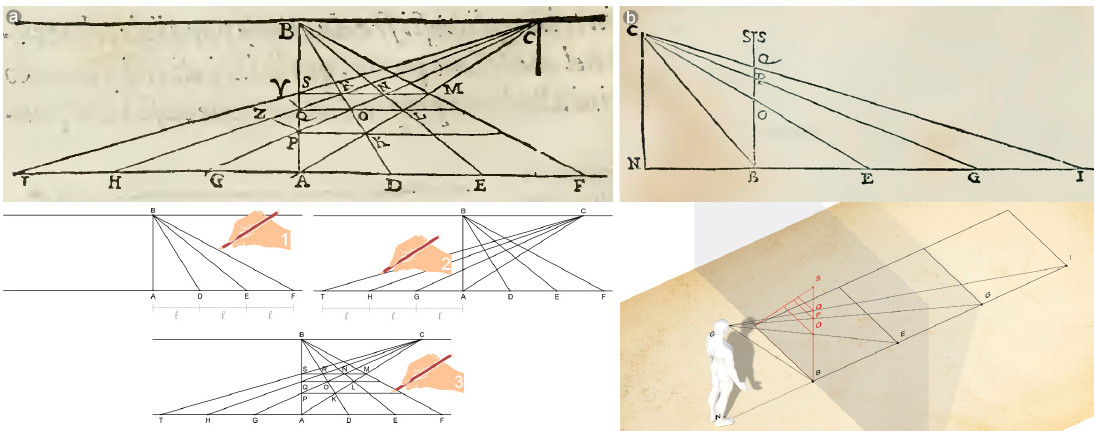
Figure 4. ( a ) Illustration of the fourth theorem, fourth proposition, contained in the introductory part of the Treaty. The theorem deals with a plan geometry problem—regarding the relationship between triangles and the parallelism between lines—that does not yet refer explicitly to prospective constructions, but is propedeutic to it; ( b ) Illustration of the XXIII theorem, XXIX proposition, contained in the introductory part of the Treaty. This theorem refers to the reduction of the apparent sizes, showing the operation of projection and section in an elevation view. It involves the principles exposed in the fourth